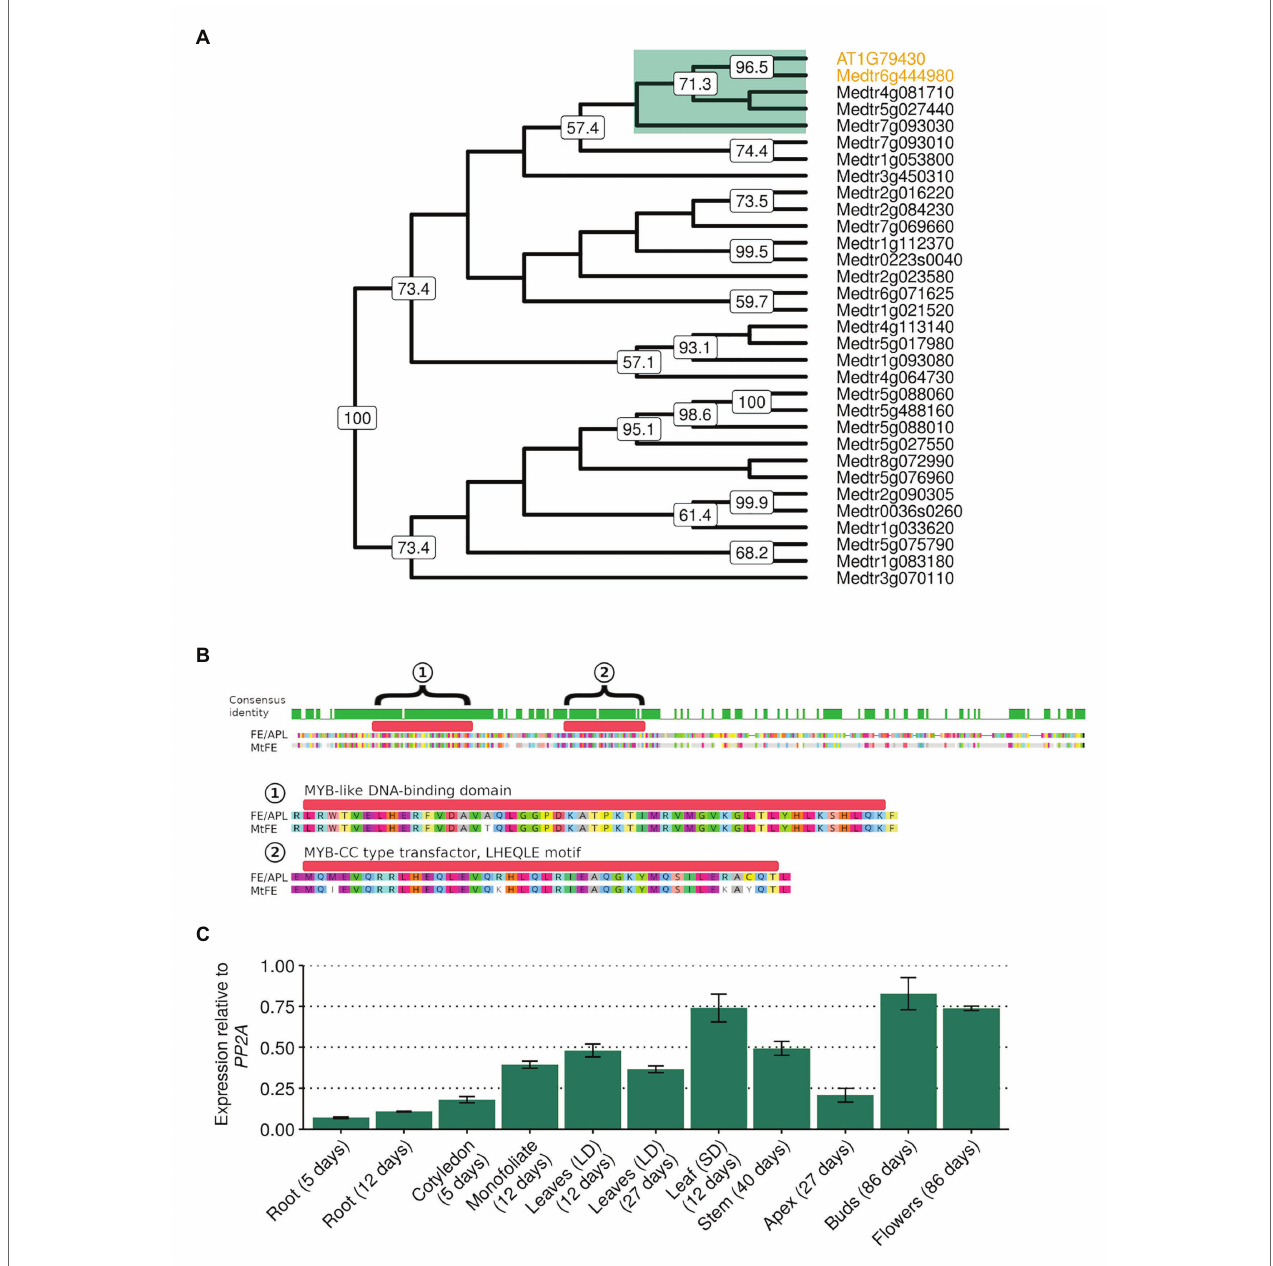
FIGURE 1 | MtFE (Medtr6g444980) sequence similarity to Arabidopsis thaliana FE/APL (At1g79430) and the broad expression of MtFE in Medicago truncatula tissues. (A) is a neighbor-joining cladogram of A. thaliana FE/APL and M. truncatula SHAQYF class MYB-like proteins after alignment with MUSCLE (Edgar, 2004). Medtr6g444980 (MtFE) and At1g79430 (AtFE/APL) are highlighted in orange. They fall into a subclade of five proteins (highlighted in green) that possess both a MYB-like DNA-binding domain (BD) and a MYB-CC type transfector, LHEQLE motif. Node numbers reflect support from 1,000 bootstraps. (B) is an alignment of MtFE to AtFE/APL. The predicted proteins are 60% identical. The green histogram above the sequence indicates areas of identical sequence with the two domains predicted by the Pfam database (https://pfam.xfam.org/) annotated and magnified below; (1) a MYB-like DNA-BD and (2) a MYB-CC type transfector, LHEQLE motif. (C) is the mean relative expression using qRT-PCR of MtFE in three independent biological replicates of different tissues harvested 2 h after dawn (ZT2) grown in long-day photoperiods (LD) unless otherwise shown (short-day photoperiods, SD). Expression is relative to the reference gene SERINE/THREONINE PROTEIN PHOSPHATASE 2A REGULATORY SUBUNIT A ( PP2A ) with error bars representing standard